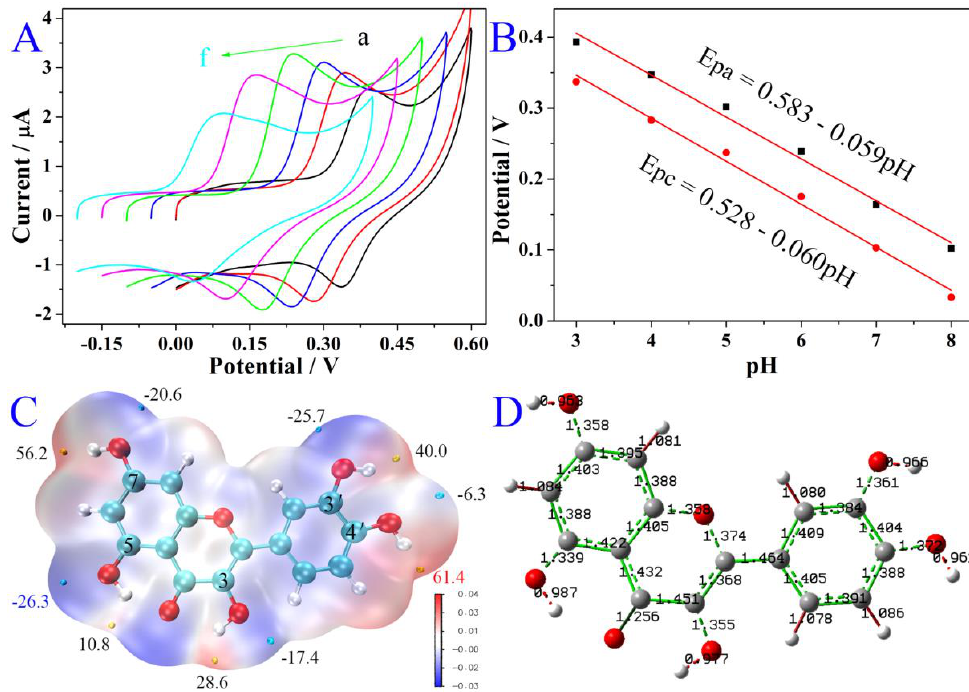
Figure 6. The CV of Cs@MoS 2 -Pd NPs/GCE in 10 µ M QR with different pHs ( A ) and their oxidation peak potential changes ( B ) from 3.0 to 8.0; the electrostatic potential( C ) and Laplacian bond order ( D ) of QR, optimized using the B3LYP functional, with the 6-311 + G(d,p) basis set.